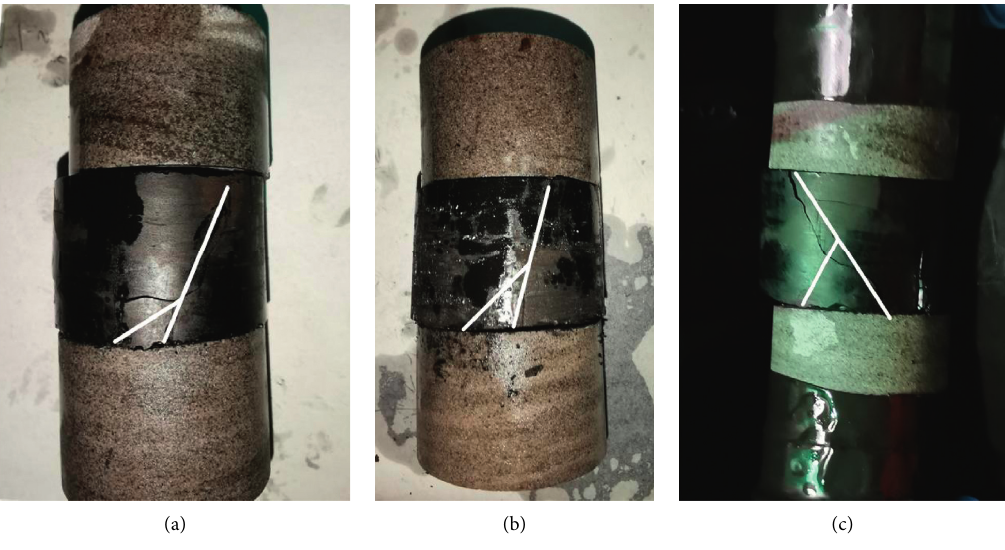
Figure 9: The results of 4# ∼ 6#. (a) 4#, (b) 5#, and (c)